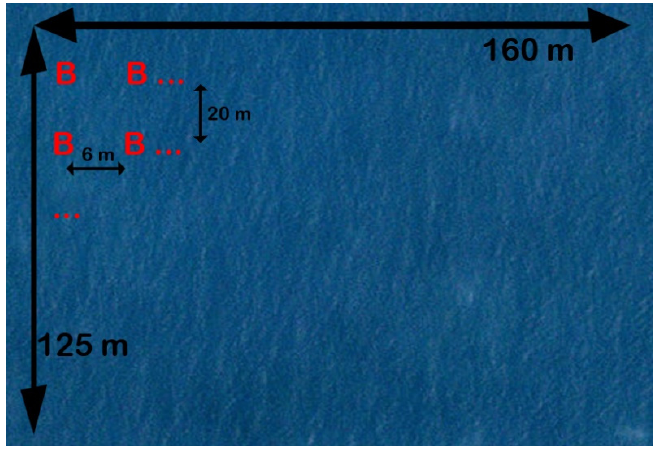
Figure 14. Scheme of the mussel farm module according to the proposed specification. B = Buoy.